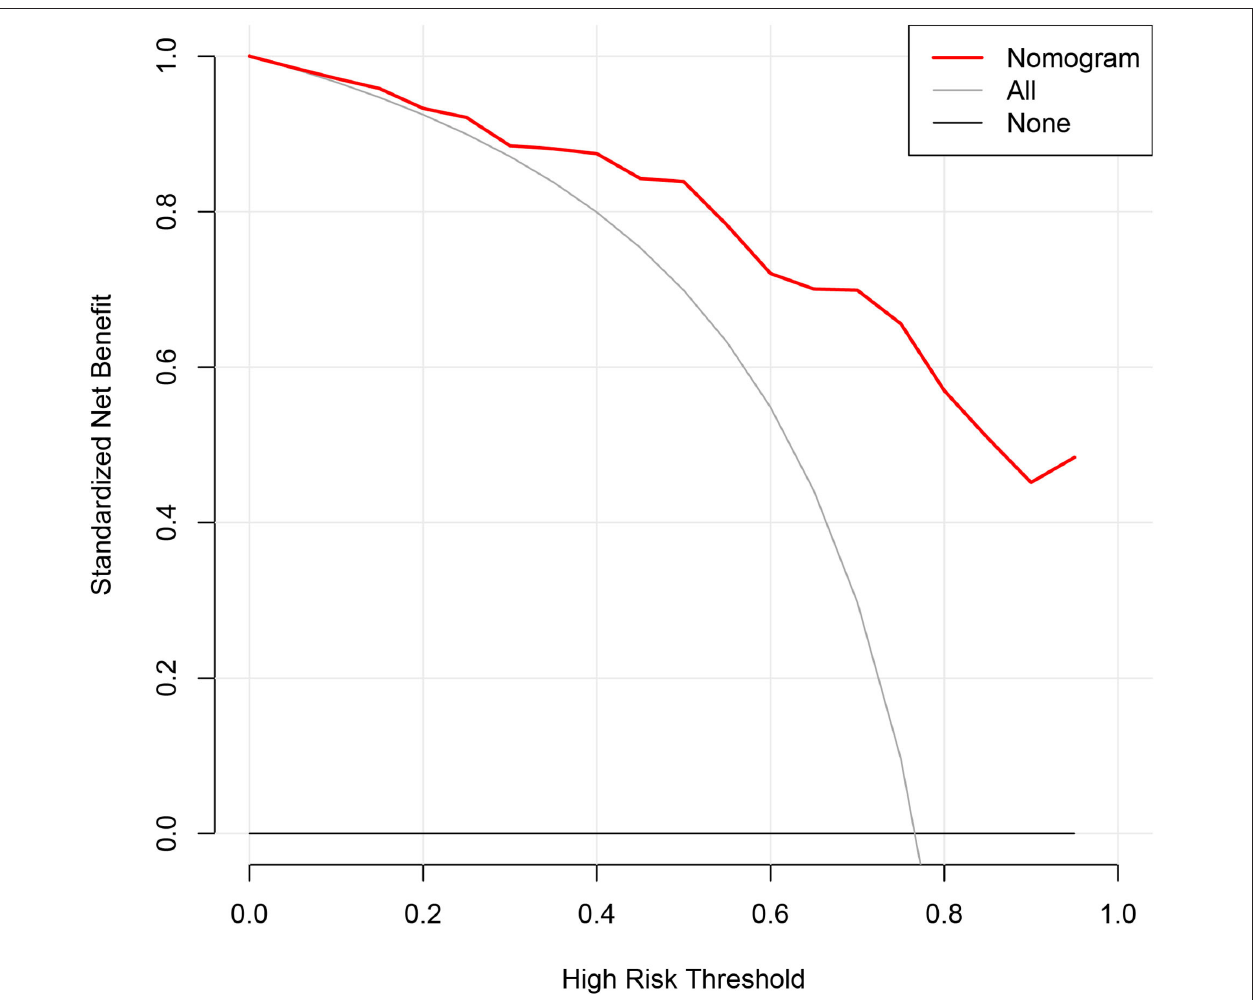
FIGURE 3 | Decision curve analysis for the nomogram. The x -axis represents the threshold probability and the y -axis measures the net benefit. When the threshold probability ranges from 14 to 88%, there is a net benefit to using this predictive model for the severity of appendicitis in young children.